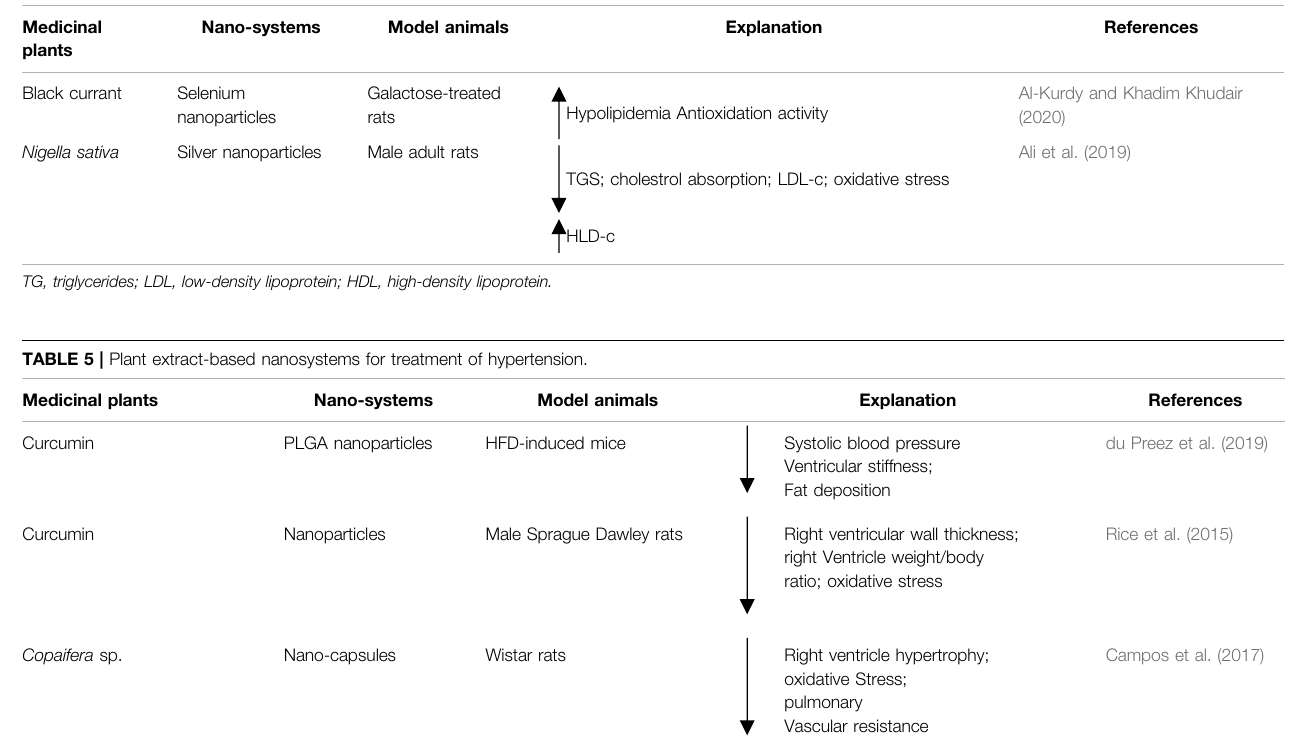
TABLE 4 | Nanosystems for dyslipidemia.